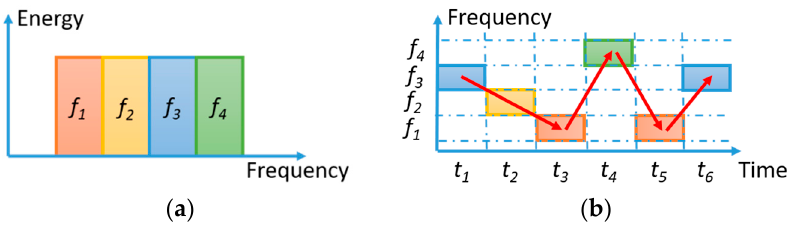
Figure 1. Principle of frequency-hopping communication systems. ( a ) Frequency channel assignment for a single user; ( b ) Time-varying spectral usage of the allocated frequency for a particular user.